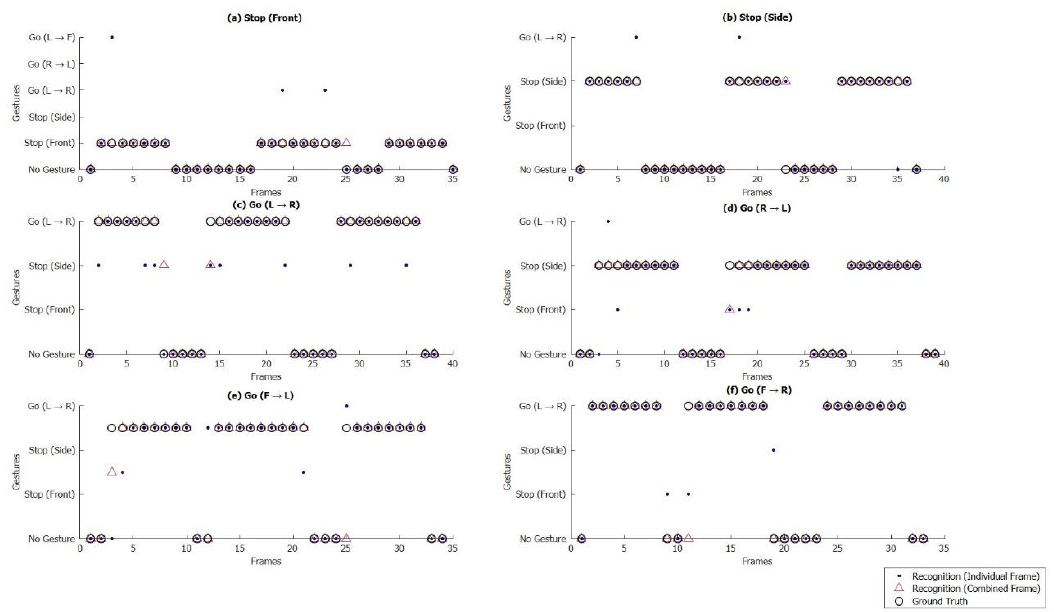
Figure 11. Frame-by-frame gesture recognition for the considered hand gestures. Individual frame recognition represents the detection using SIN, and the combined frame recognition shows the combined result of CEN and SIN for each frame.